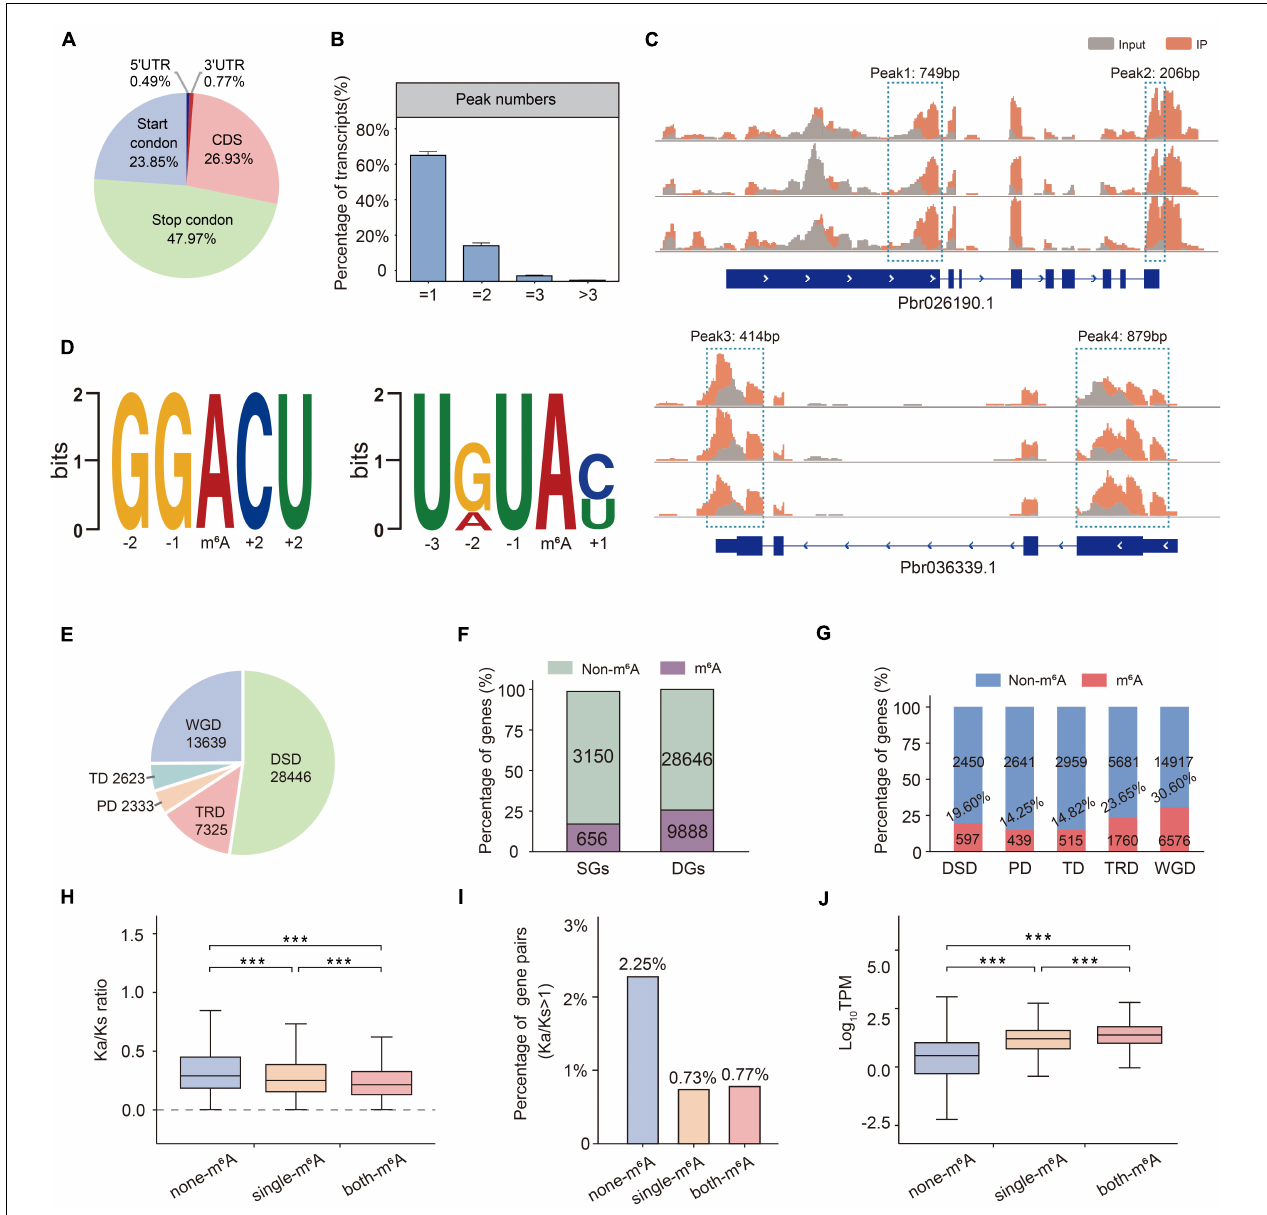
FIGURE 4 | Overview of m 6 A methylation profiles in pear. (A) Percentage of total m 6 A peaks located throughout the regions of mRNA transcript. (B) Proportions of different m 6 A peak numbers in m 6 A-modified transcripts. Error bars represent the SD of three biological repeats. (C) Two examples of m 6 A-modified transcripts each containing two peaks at start codon, stop codon, and CDS (coding sequence). (D) Sequence motif identified by MEME. (E) The number of gene pairs derived from five duplication types in pear. (F) Comparison of ratios of m 6 A genes and non-m 6 A genes in SGs and DGs. (G) Comparison of ratios of m 6 A genes and non-m 6 A genes in five duplication S types. (H) K a /K s ratio of non-m 6 A gene pairs (blue box), single gene pairs (orange box), and both-m 6 A gene pairs (red box) in WGD. (I) The percentages of gene pairs showing K a /K s > 1 in WGD. (J) Expression divergence among duplicate genes derived from non-m 6 A, single-m 6 A, and both-m 6 A in